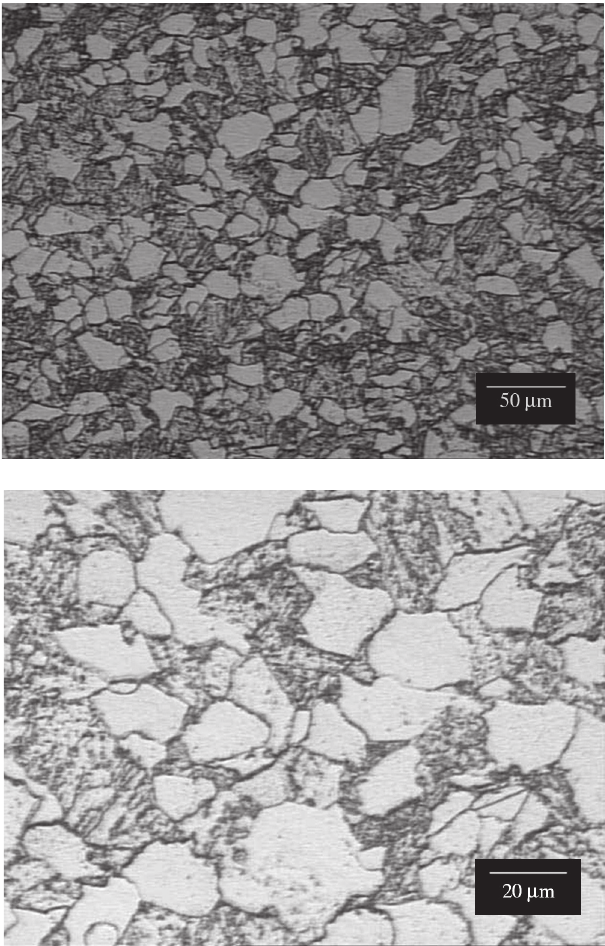
Figure 3. Optical micrographs of the 2.25Cr-1Mo steel in the as received condition. Etching reagent: Nital